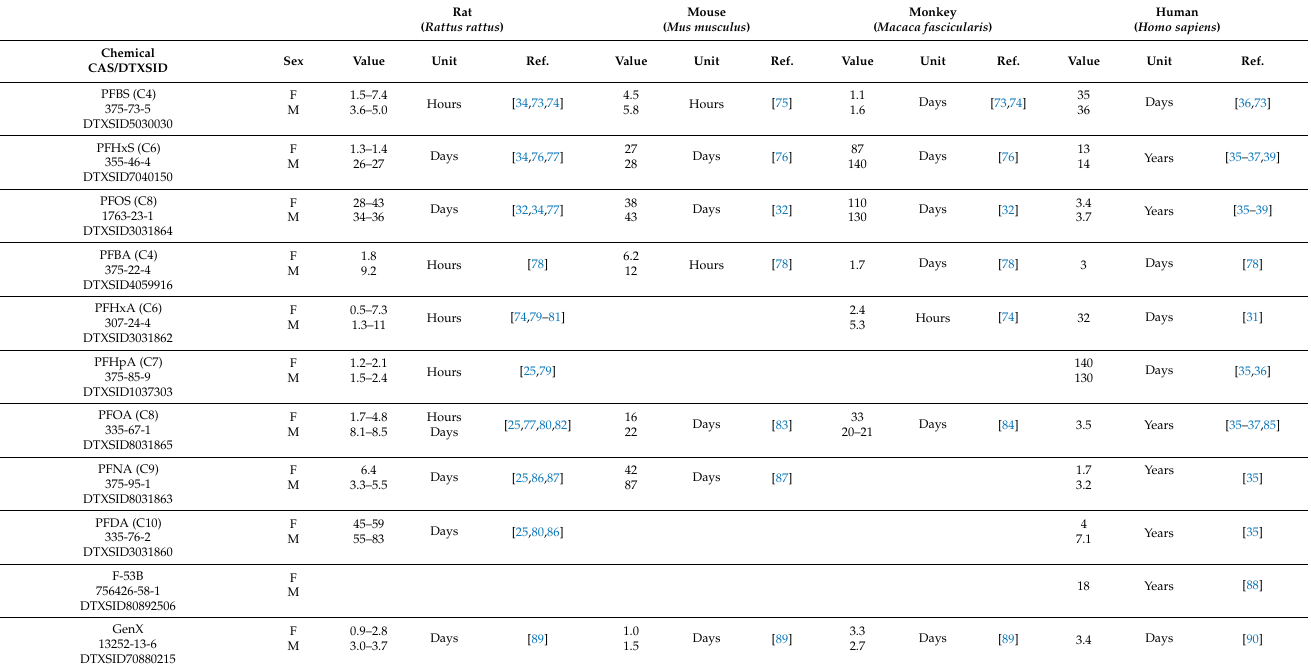
Table 1. PFAS t 1 life estimates used in model construction (full data set is provided in Table S3). Data 2 adopted from Fenton, Ducatman, Boobis, DeWitt, Lau, Ng, Smith and Roberts [11] was augmented by new studies wherever available. Values for chemical/species combinations that were not available were omitted from modeling, but values only available for one sex of a species were assumed to be same for both. Rat Mouse Monkey Human ( Rattusrattus ) ( Musmusculus ) ( Macacafascicularis ) ( Homosapiens